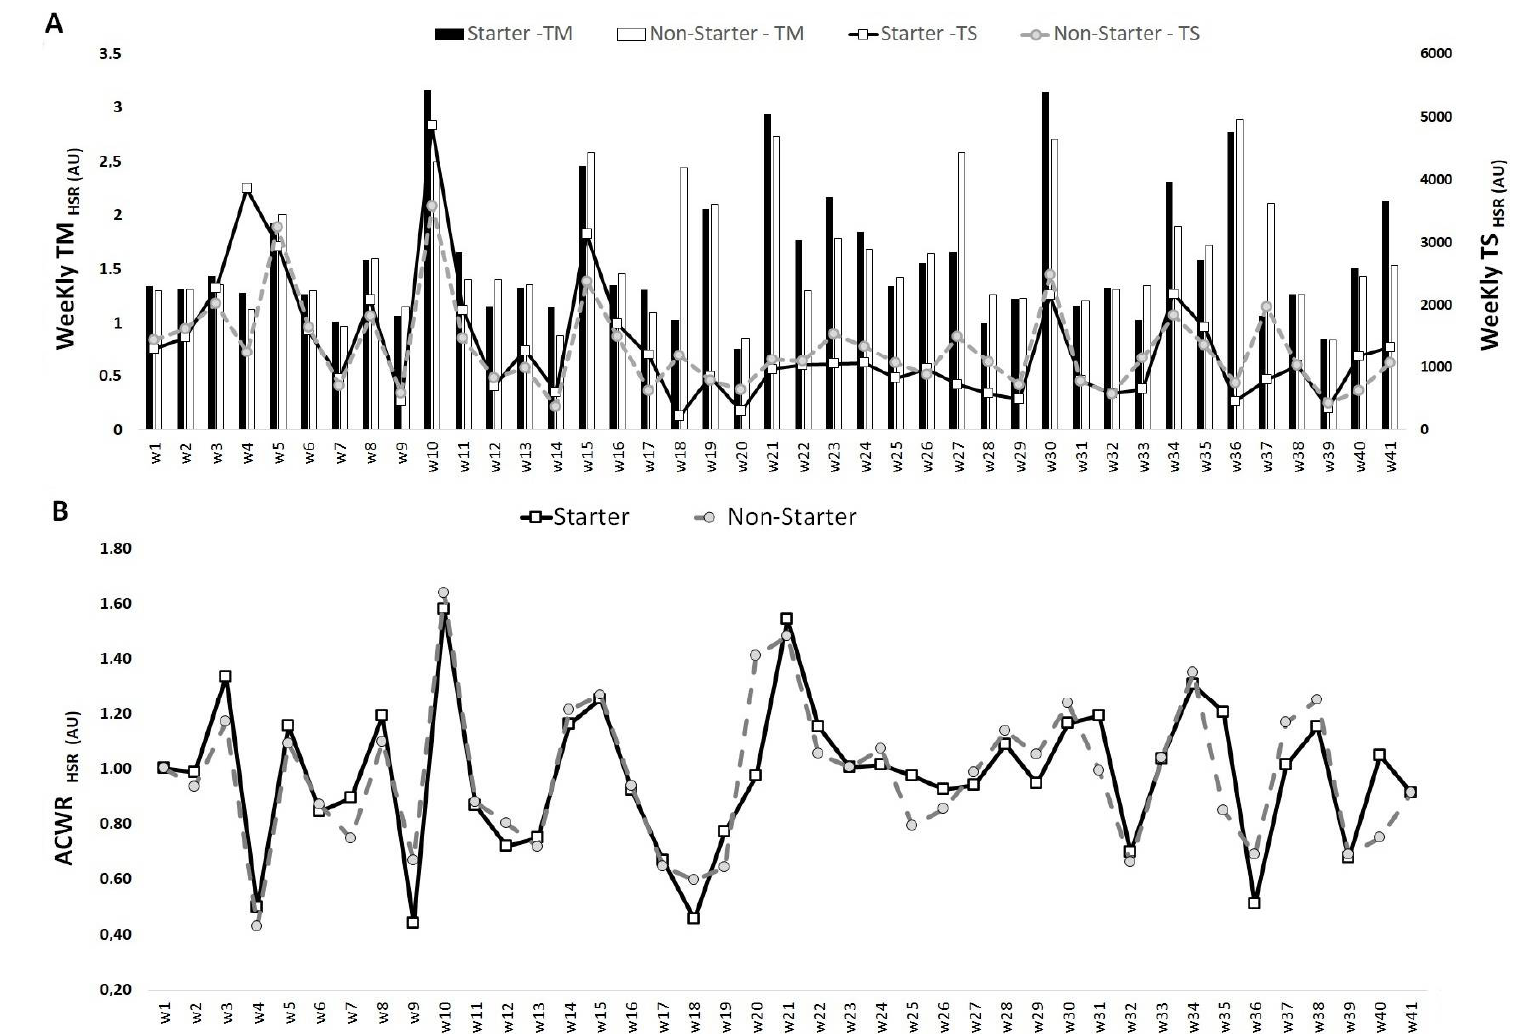
Figure 3. TM , TS ( A ) and ACWR ( B ) variations calculated through the HSR across 41 weeks for starters and non-starters.